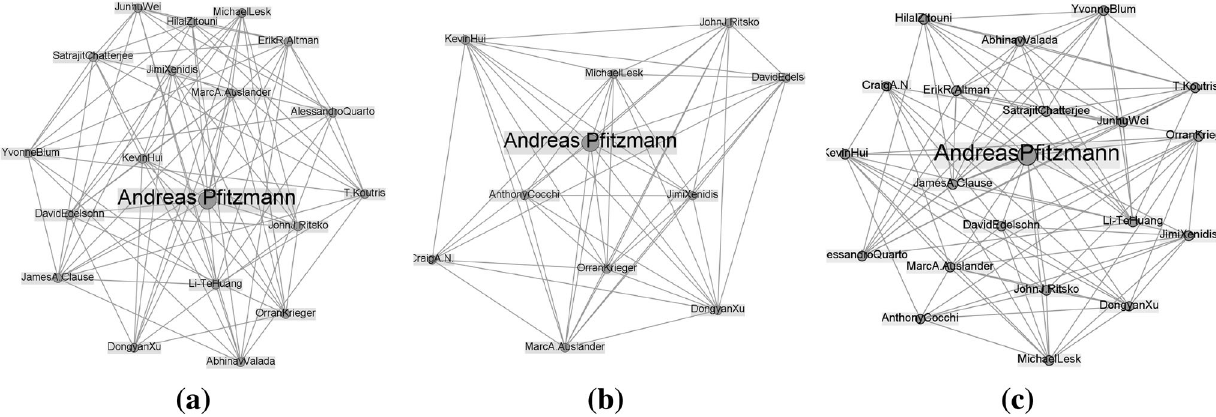
Fig. 10 Query node ‘‘Andreas Pfitzmann’’ in different models. a (8-core with 19 nodes,83 edges). b (8-truss with 11 nodes,50 edges). c (8-core- truss 21 nodes,97